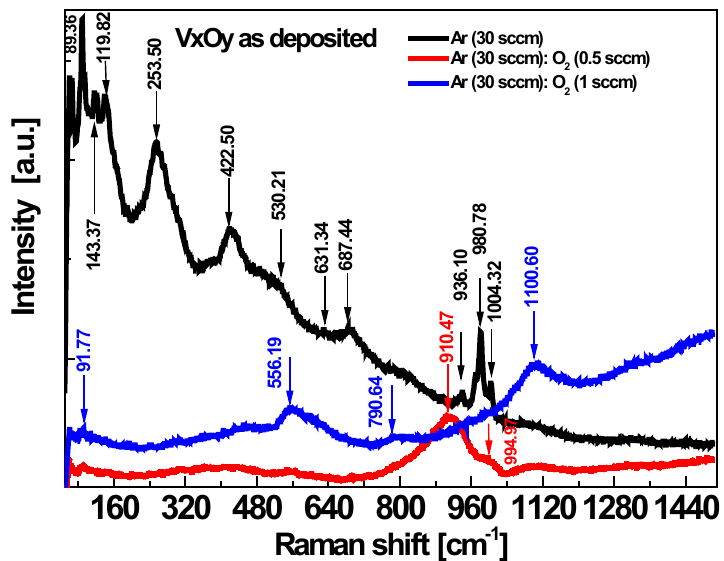
Figure 2. Raman spectra of the as − deposited V x O y films. The Raman spectrum of the film obtained in process (A) shows several sharp intense maxima located in the 89.36–143.37 cm −1 region, as well as at 253.50 cm −1 , 422.50 cm −1 , 530.21 cm −1 , 631.34 cm −1 , 687.44 cm −1 , 936.10 cm −1 , 980.78 cm −1 and 1004.32, while the Raman spectrum of the film obtained in process (B) presents only a low intensity, broad peak centered at 910.47 cm −1 with a shoulder at 994.97 cm −1 . The Raman spectrum of the film obtained in the richest atmosphere of O 2 , i.e., process (C), exhibits broad and weak peaks positioned at 556.19 cm −1 , 790.64 cm −1 and 1100.60 cm −1 , respectively. The major vibrational region in the Raman spectra of vanadium oxide systems is situated in the 100–1200 cm −1 range and covers: V − 0 terminal stretching that occurs at 770–1050 cm −1 , the V − 0 − V stretch- ing region at 500–800 cm −1 and the bending mode at 150–400 cm −1 . Lattice vibrations of crystalline compounds may also be present below 150 cm −1 [33].